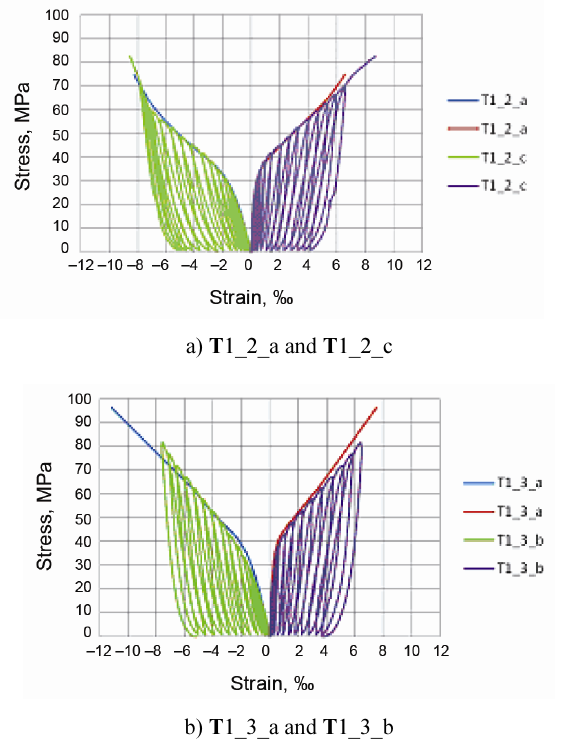
Fig. 11. Cyclic and monotonic stress-strain curves for T1_2_a/c and T1_3_a/b specimens